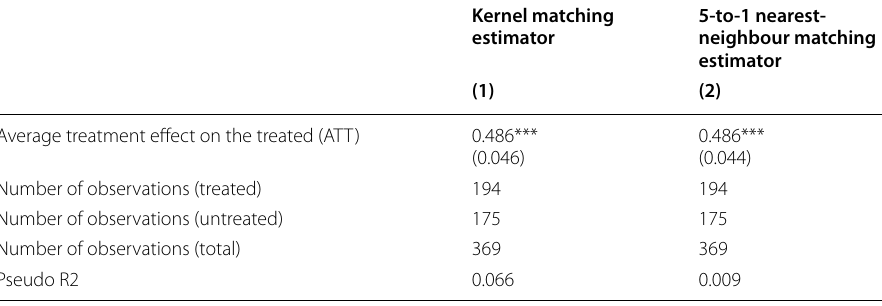
Table 4 Estimate impacts of informal institutions on youth participation in the agribusiness sector—PSM results. Source : Authors’ computations,